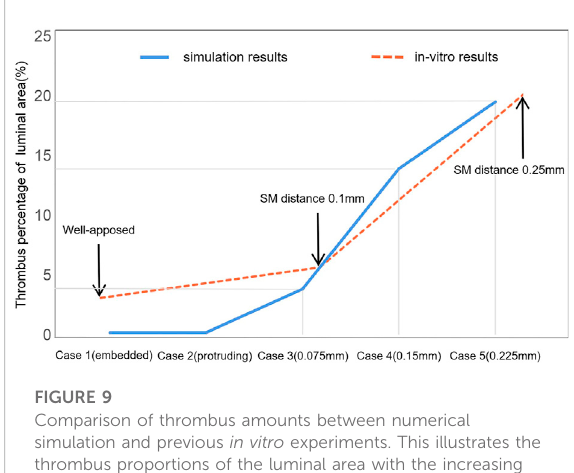
FIGURE 9 Comparison of thrombus amounts between numerical simulation and previous in vitro experiments. This illustrates the thrombus proportions of the luminal area with the increasing detachment distance. The two sets of results share the same axial